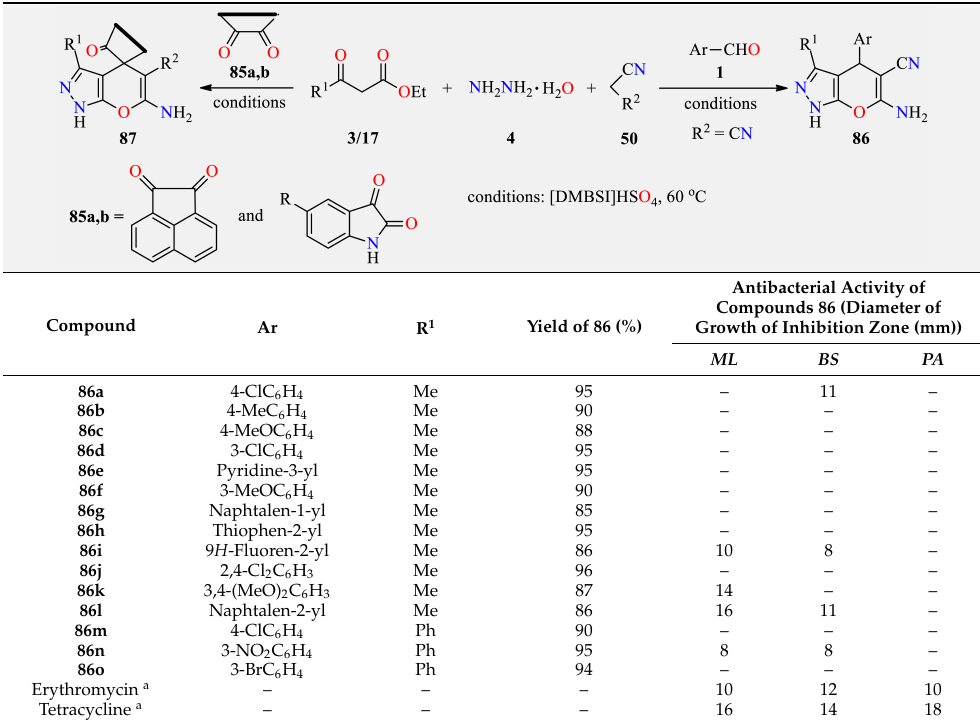
Table 21. Four-component synthesis of pyrano[2,3- c ]pyrazoles 86 and their in vitro antibacterial activity against three bacterial strains.